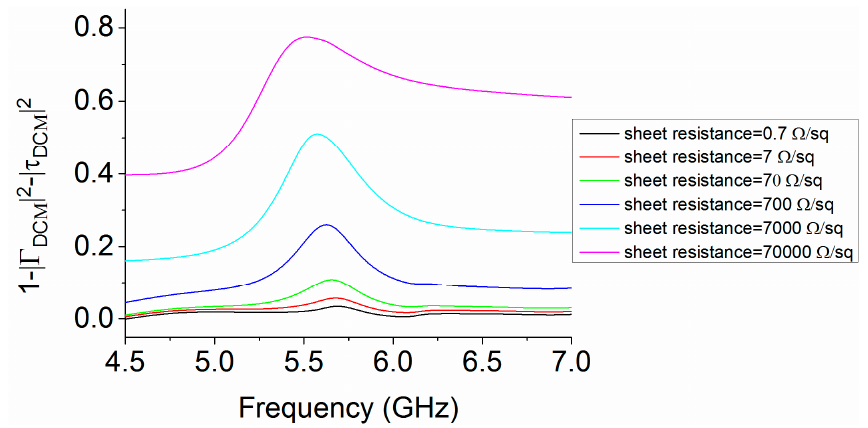
Figure 8. Losses of MS with di ff erent values of sheet